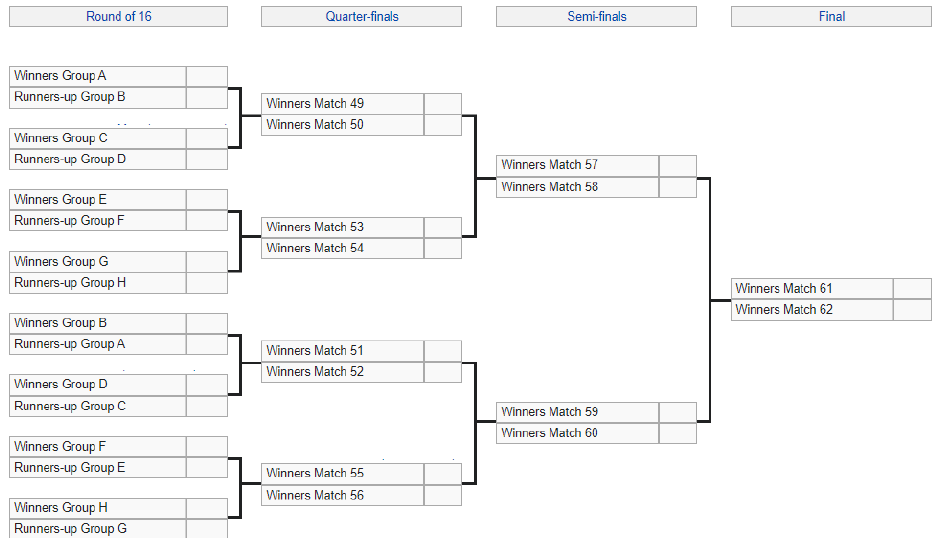
Figure 8. Schematic of the final phase.